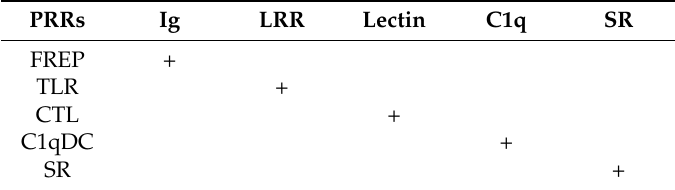
Table 2. The main recognition domains of various pattern recognition receptors (PRRs).